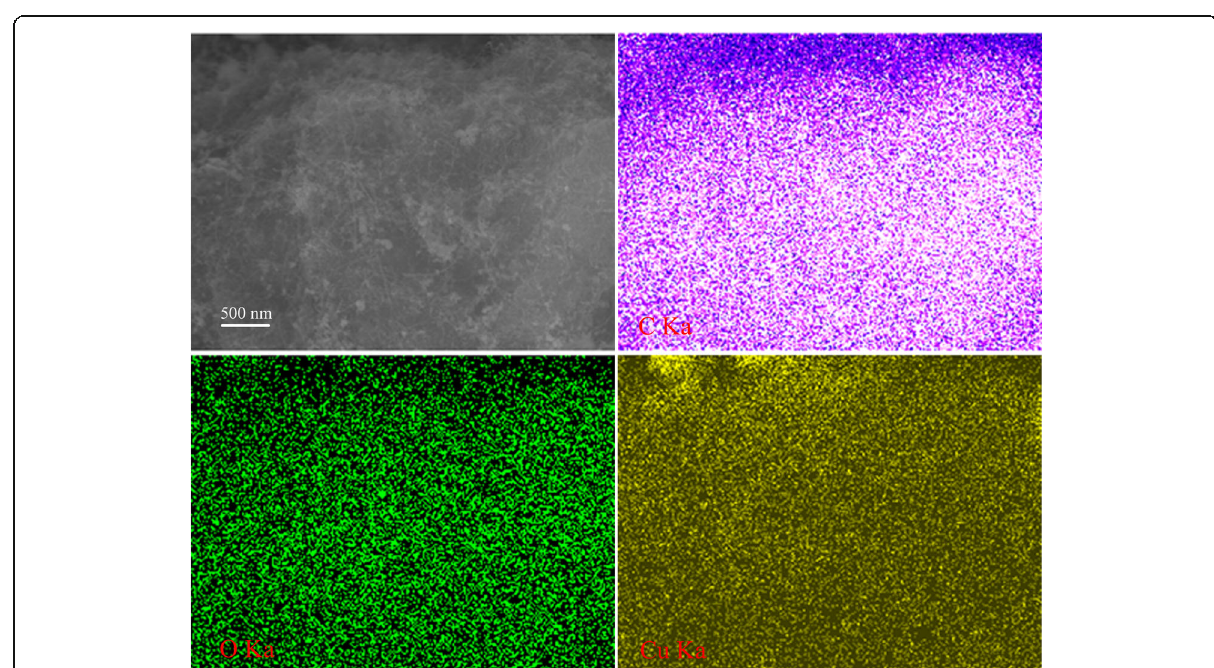
Fig. 2 SEM image of CNT-Cu-30-1 nanocomposite and elemental mappings of C, O, and Cu